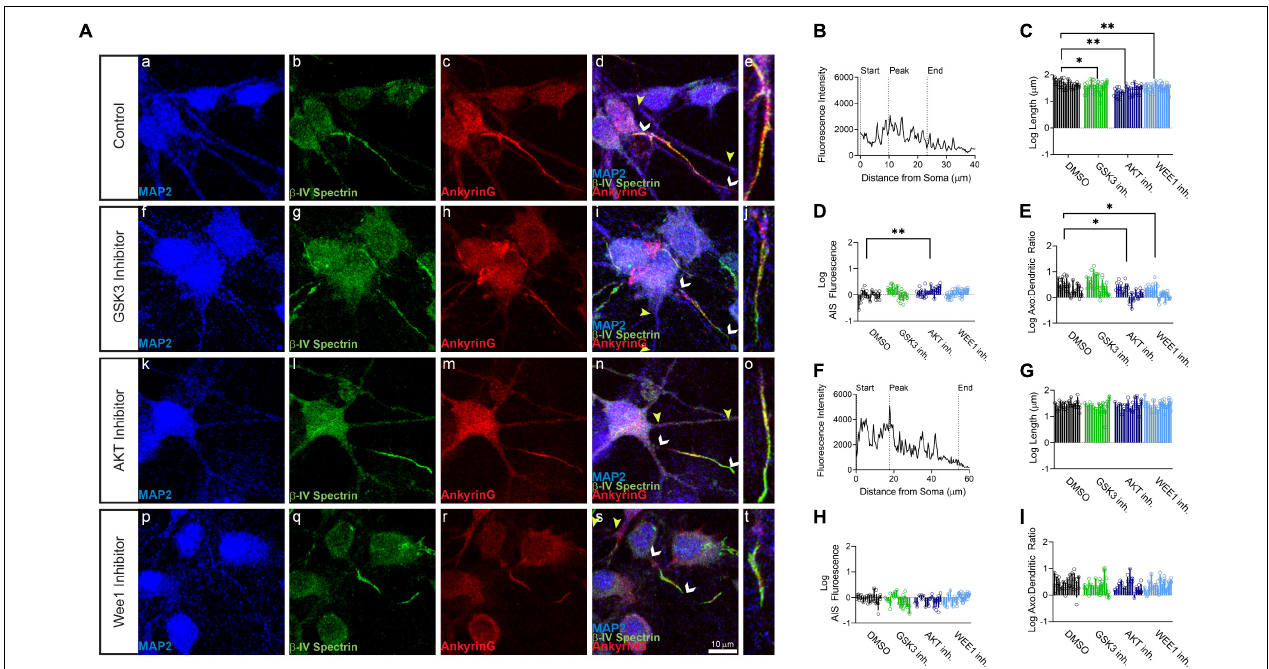
FIGURE 1 | β IV spectrin but not ankyrinG is sensitive to kinase perturbation at the axon initial segment (AIS) and dendrites of primary hippocampal neurons. (A) Representative images of expression of (a,f,k,p) MAP2 (blue), (b,g,l,q) β IV spectrin (green), (c,h,m,r) ankyrin G (red), and (d,i,n,s) merge of all channels with white arrows indicating the AIS and yellow arrows indicating a dendrite, (e,j,o,t) zoom to AIS. (a–e) Neurons treated with 0.5% DMSO (control). (f–j) Neurons treated with 5 µ M GSK3 inhibitor CHIR99021. (k–o) Neurons treated with 25–30 µ M AKT inhibitor triciribine. (p–t) Neurons treated with 5–10 µ M Wee1 kinase inhibitor II. (B) Profile of β IV spectrin fluorescent intensity from the AIS highlighted in panel (e) with the peak of fluorescent intensity, AIS start and AIS end noted as described in the “Materials and Methods”. (C) The length of the β IV spectrin from the AIS is significantly decreased after treatment with the GSK3 inhibitor CHIR99021 ( p = 0.0203), AKT inhibitor triciribine ( p < 0.0001), or Wee1 kinase inhibitor II ( p = 0.0012). (D) Fluorescent intensity of β IV spectrin at the AIS is increased following treatment with the AKT inhibitor triciribine ( p = 0.0091). (E) The axo:dendritic ratio of β IV spectrin is decreased in neurons following treatment with either triciribine ( p = 0.0332) or Wee1 kinase inhibitor II ( p = 0.0163). (F) Profile of ankyrin G fluorescent intensity from the AIS highlighted in panel (e) with the peak of fluorescent intensity, AIS start and AIS end noted as described in the “Materials and Methods”. (G) None of the kinase inhibitors examined altered the length of the ankyrin G from the AIS (GSK3 inhibitor p = 0.6218; AKT inhibitor p = 0.9888; Wee1 kinase inhibitor II p = 0.9996), (H) the fluorescent intensity of ankyrin G at the AIS (GSK3 inhibitor p = 0.2062; AKT inhibitor p = 0.3289; Wee1 kinase inhibitor II p > 0.9999), or (I) axo:dendritic ratio (GSK3 inhibitor p = 0.2780; AKT inhibitor p = 0.3225; Wee1 kinase inhibitor II p = 0.5952). All data are mean ± SEM using a separated scatter graph with bars ∗ p < 0.05 and ∗∗ p < 0.01 by Nested One-Way ANOVA with Dunnett’s multiple comparisons